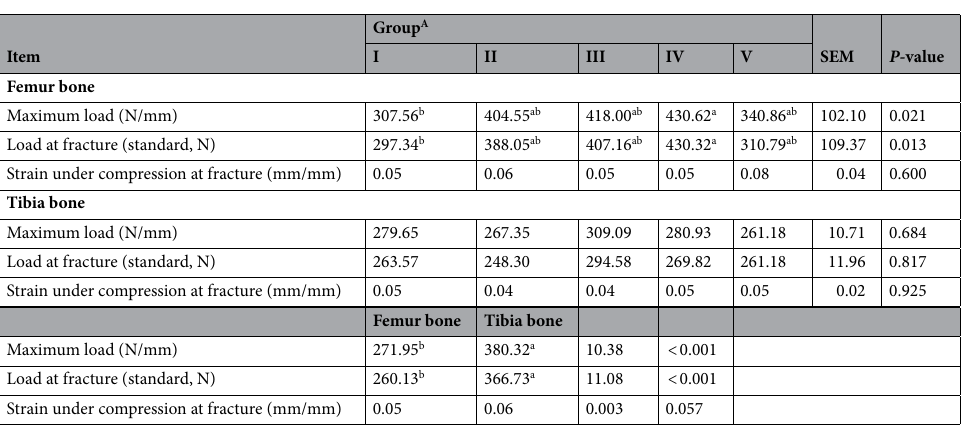
Table 5. Breaking strength of femur and tibia bones of broiler chickens. SEM standard error of the mean. a,b Values with different letters in a row differ significantly, P < 0.05. A Groups II, III, IV, V were fed with halloysite and zeolite (1:3 ratio) at 0,5% (1–35 days) and 1% (36–42 days) level. Aluminosilicates were also used for the litter: II—500 g of halloysite/m 2 ; III—250 g of halloysite/m 2 and 250 g of zeolite/m 2 ; IV—500 g of zeolite/m 2 ; V—130 g halloysite/m 2 , 370 g zeolite/m 2